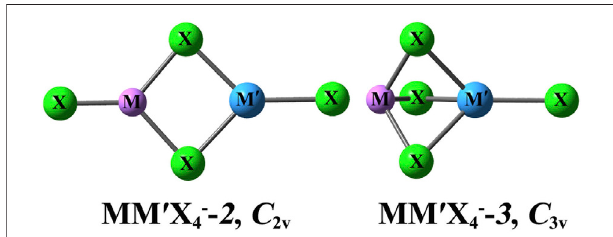
FIGURE 1 | Optimized structures of the MM ′ X 4 − anions at the MP2/ 6 – 311+G (3df) level. Color legend: green for X atom, light purple for M atom, and blue for M ′